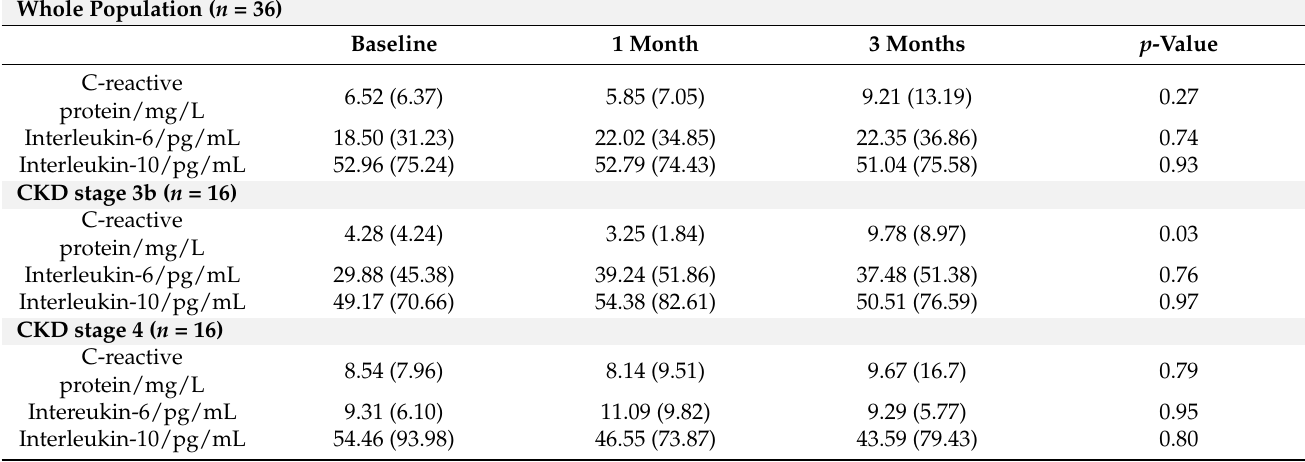
Table 2. Markers of inflammation.